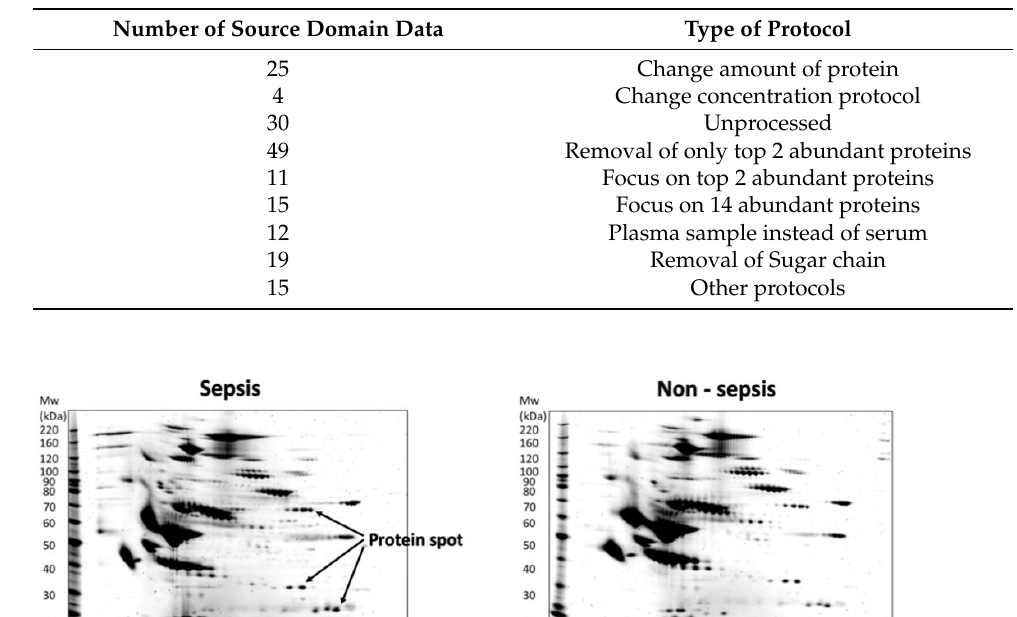
Table 3. List of source 2D-GE images. The total number of source images is 180, and the number of source domain labels is 9.